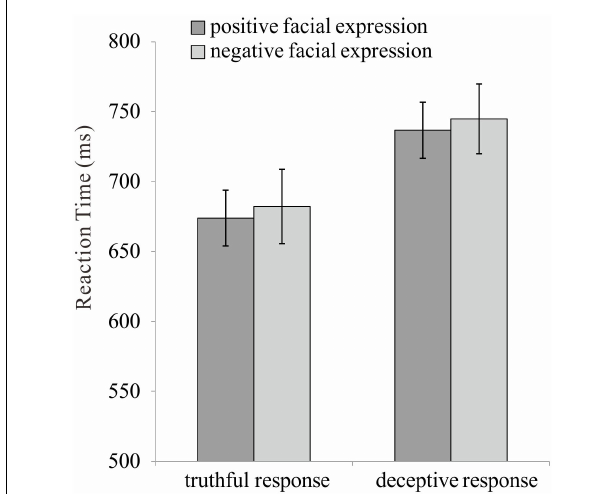
FIGURE 2 | The reaction time for positive and negative facial expression under truthful and deceptive